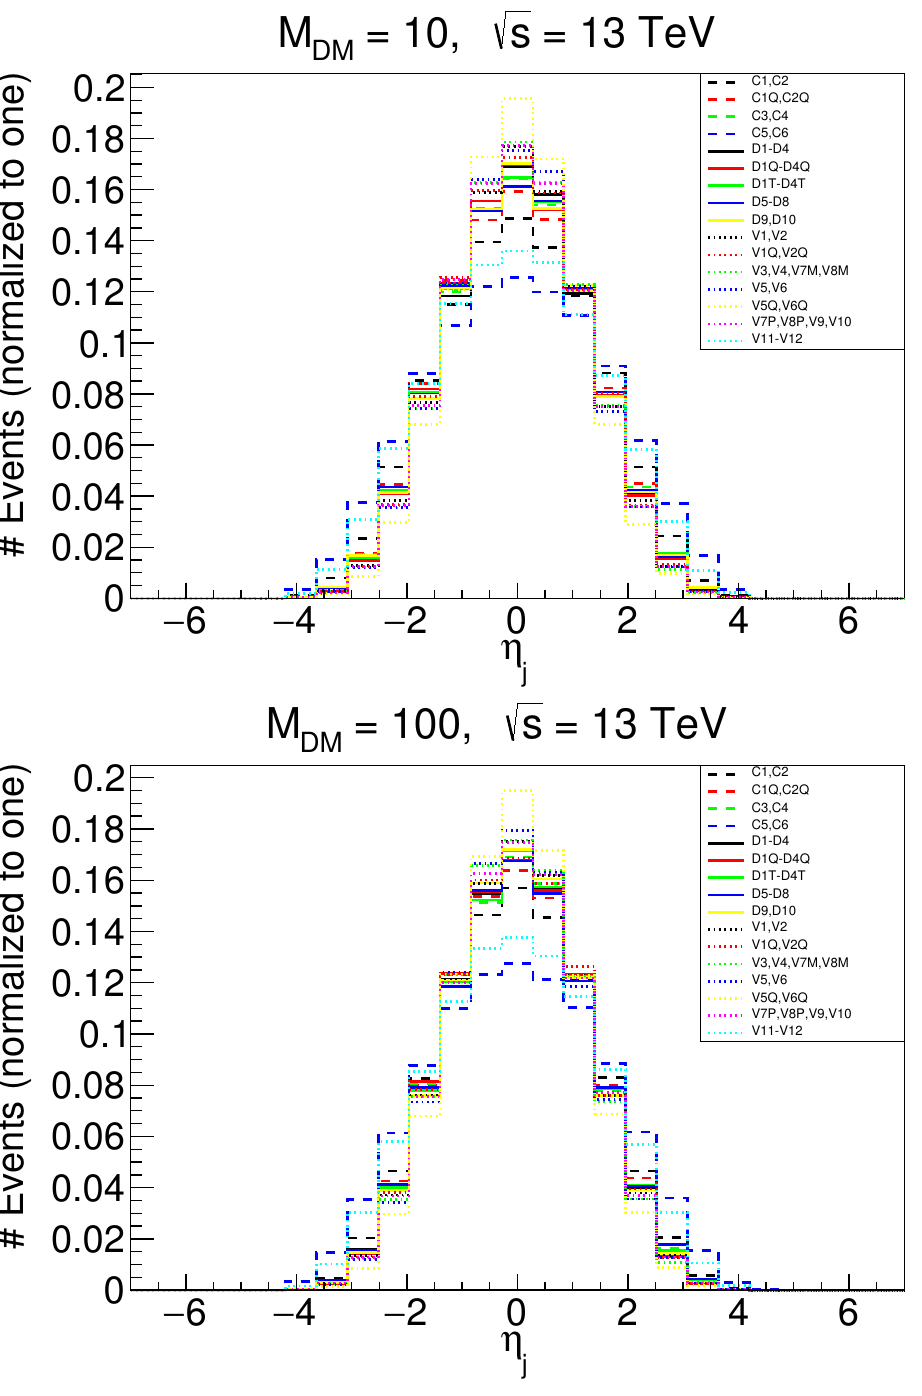
Figure 5 . Pseudorapidity of the mono-jet distributions normalised to unity for EFT operators listed in tables 1 and 2 for 13 TeV LHC energy, M DM = 10(top) and 100(bottom) GeV and p T; jet (cid:21) 100 GeV cut applied.